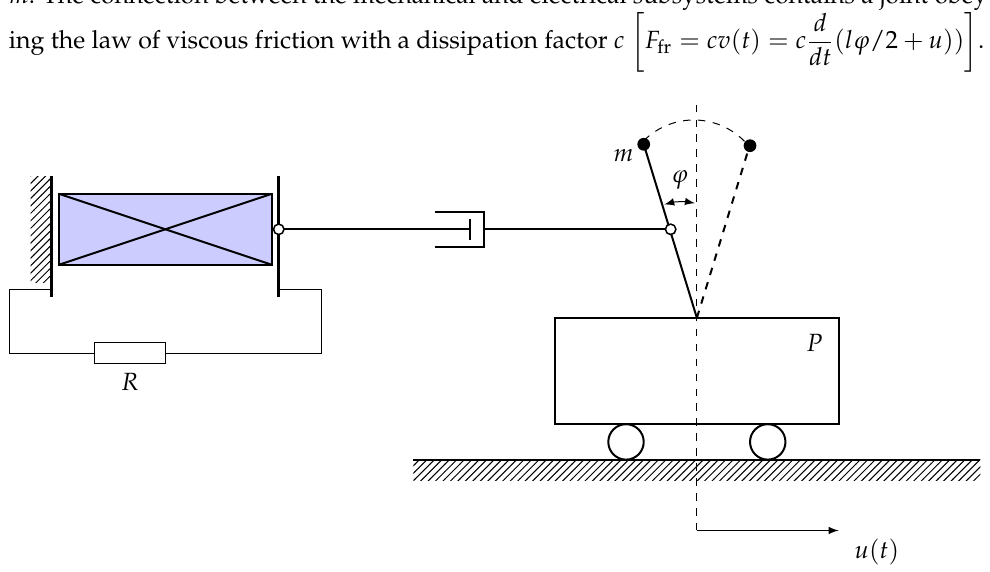
Figure 1. Schematic description of a mathematical pendulum connected to a piezoelectric